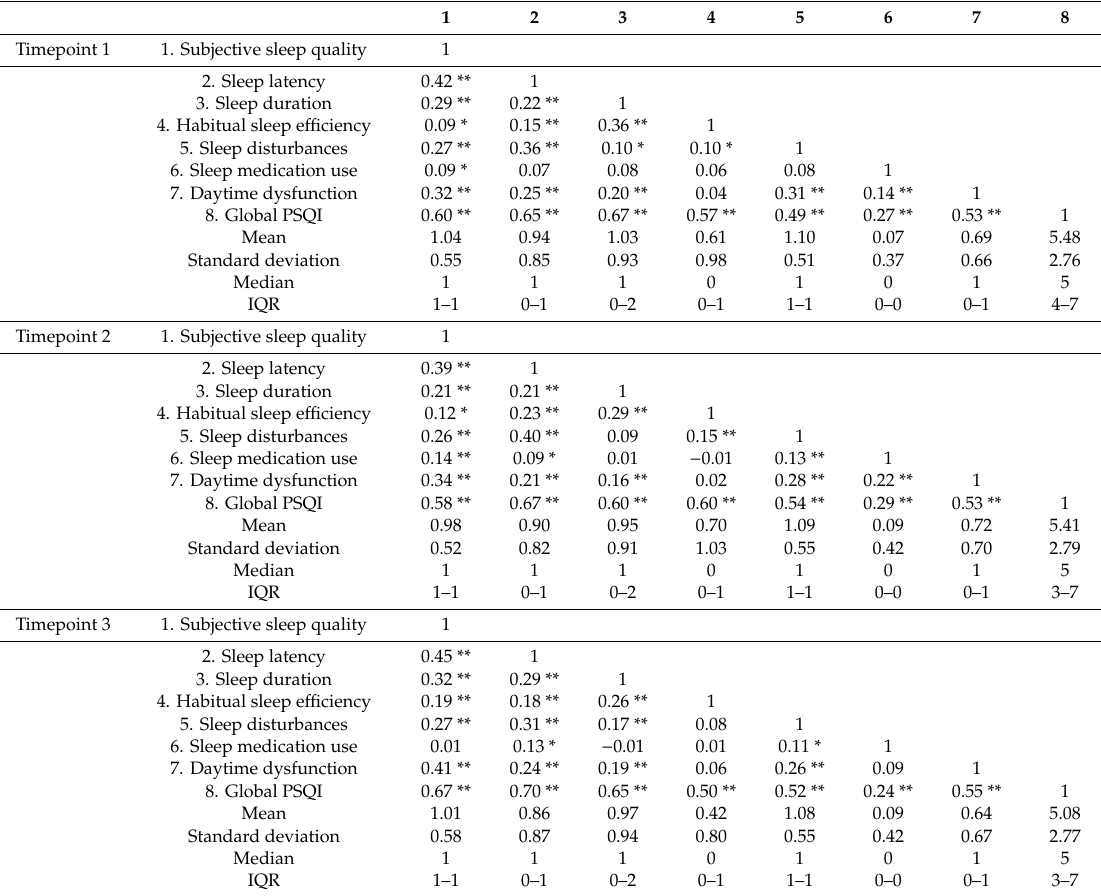
Table 2. Pittsburgh Sleep Quality Index (PSQI) inter-component Spearman’s correlations and descriptive statistics for each